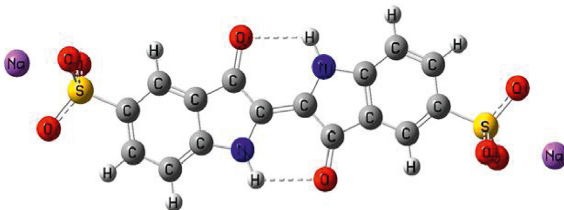
Figure 2: 3D structure of indigo carmine (C